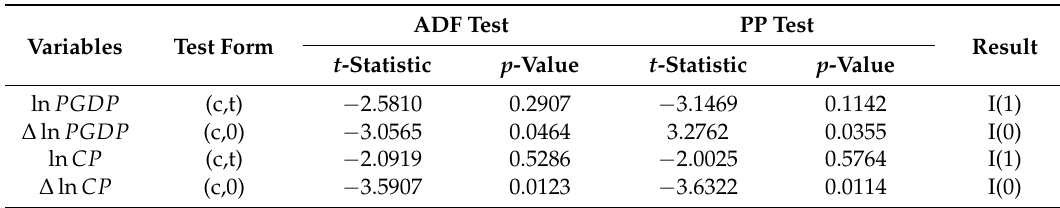
Table 1. Unit root test results.